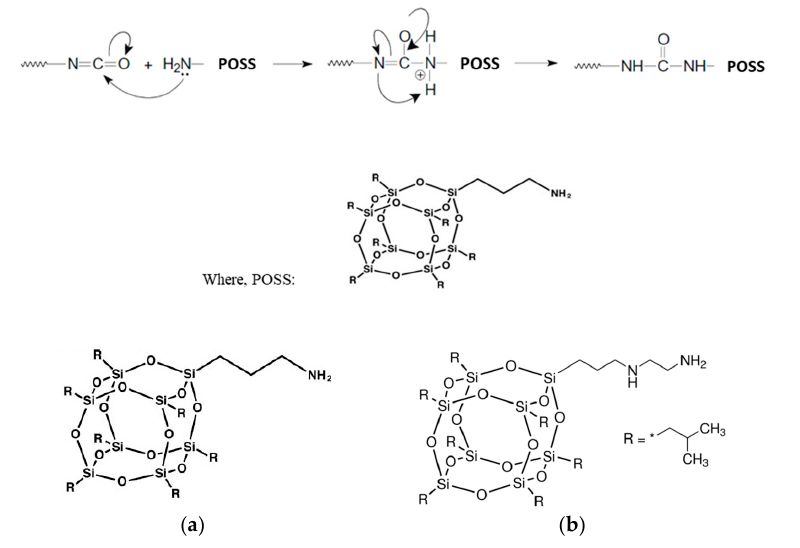
Figure 2. APIB-POSS and AEAPIB-POSS observed by a magnification of 50.